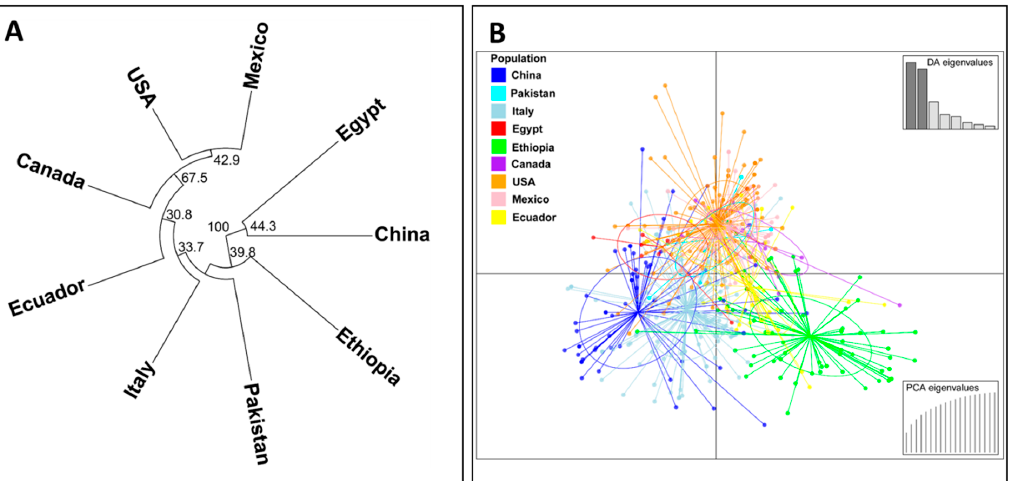
Figure 5. A phylogenetic tree showing the relationships of Puccinia striiformis f. sp. tritici ( Pst ) collections from nine countries based on the Edward’s genetic distance ( A ) and a scatter plot based on the discriminant analysis of principal component (DAPC) analysis of all Pst isolates across the nine countries ( B ).